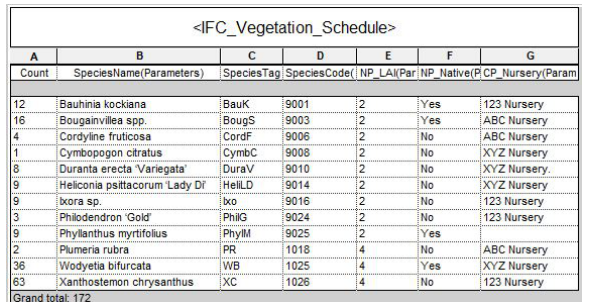
Figure 18. Imported IFC files with all the custom parameters (CP and NP).